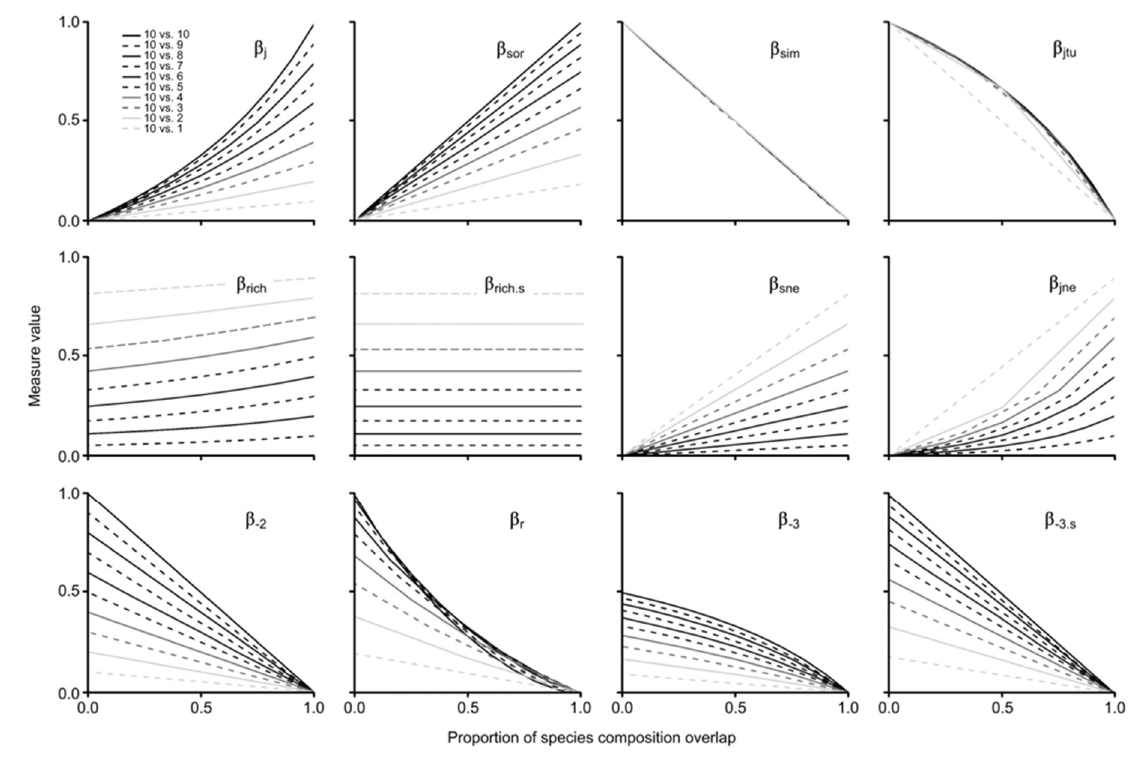
Figure 4. Gradual species composition overlap between paired assemblages considering progressive differences in species richness.